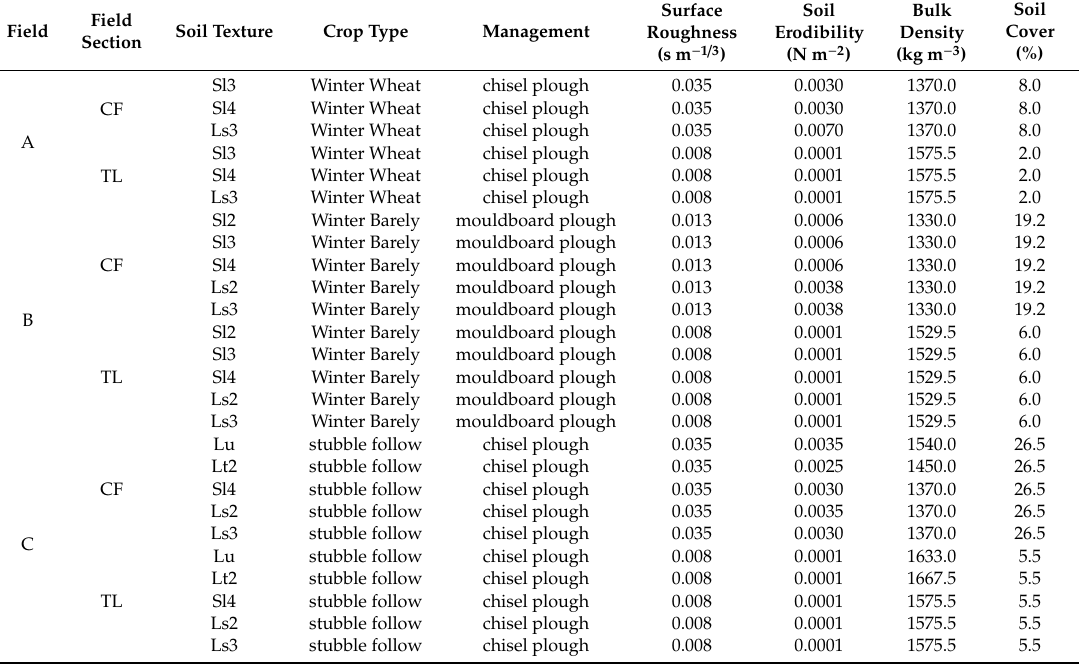
Table A2. Adapted input parameters for cultivated field (CF) and tramline sections (TL) in EROSION 3D using DPROC and the parameter catalogue of Sachsen in dependence of soil texture, crop type and management